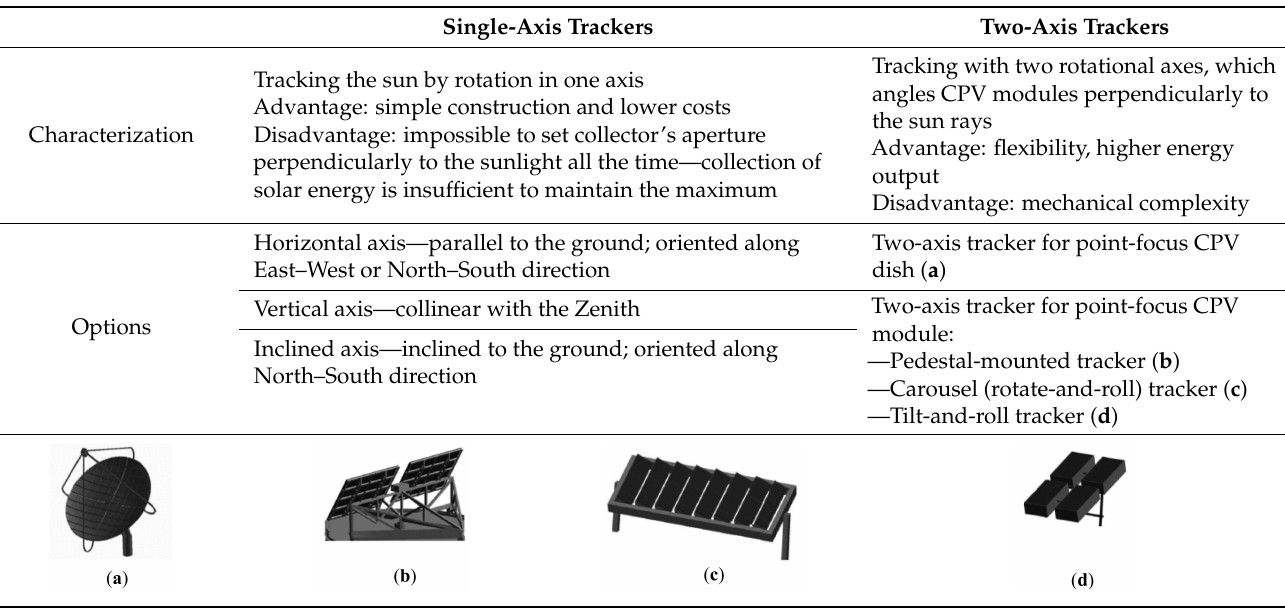
Table 1. Types and characterization of sun trackers for CPV according to Fern á ndez et al. [38].